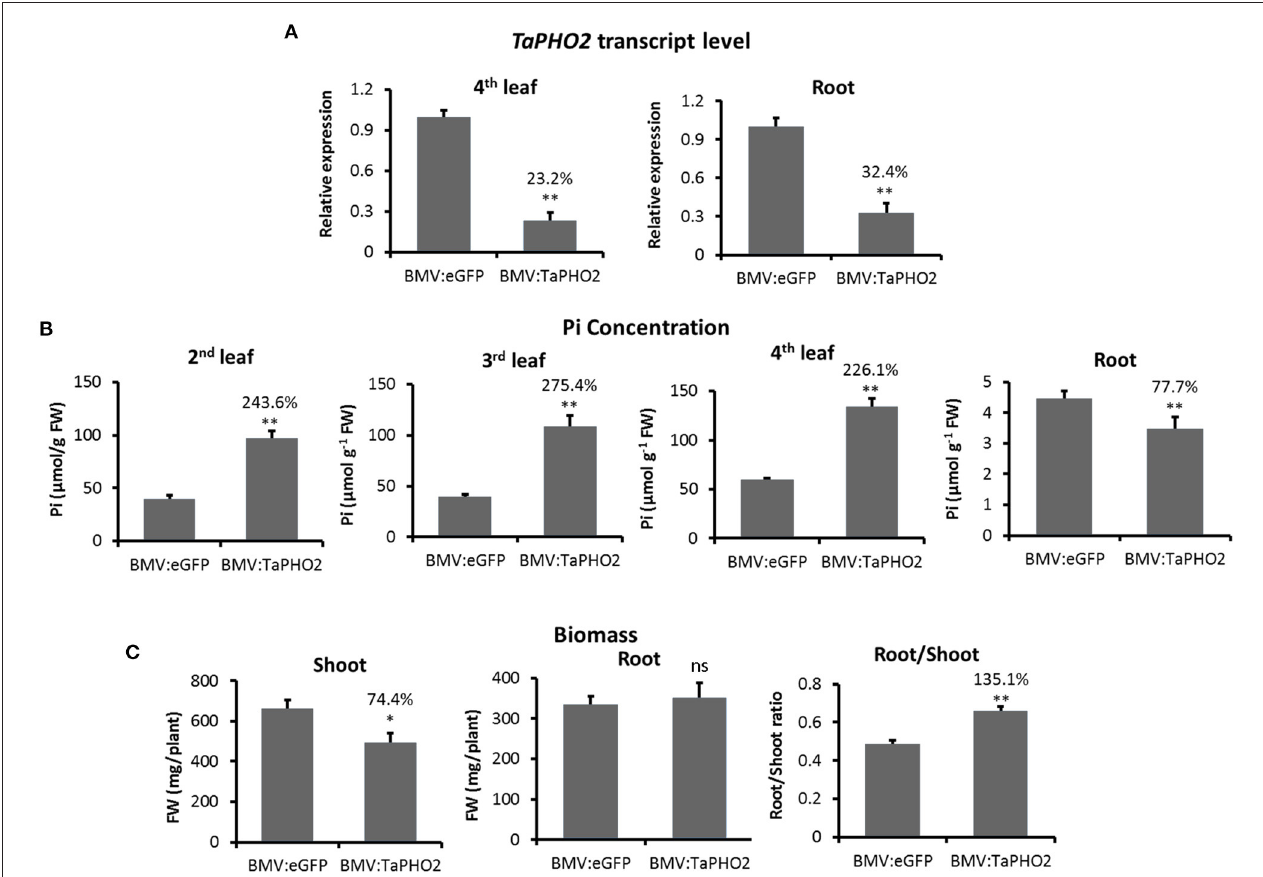
FIGURE 6 | Inorganic phosphate concentration and biomass of wheat plants silenced for TaPHO2 expression with BMV:TaPHO2 114 infection. Wheat ( cv. Overley) plants inoculated with BMV:TaPHO2 (114-nt insert) or BMV:eGFP (107-nt insert; control) were grown under a low phosphate condition (20 µ M Pi). Samples were collected at 24 dpi. (A) TaPHO2 expression levels in the 4th systemic leaf or roots, determined by RT-qPCR with values across treatments normalized against relative TaEF1 α mRNA levels. (B) Pi concentrations in the 2nd, 3rd, or 4th systemic leaves or roots of plants inoculated with BMV:TaPHO2 or BMV:eGFP. (C) Shoot biomass, root biomass and Root/Shoot ratio of plants inoculated with viruses. Percentage values are relative to the BMV:eGFP control. Values represent means + SE of five biological replicates and treatment values compared ( t -test; * P < 0.05; ** P < 0.01). Similar results were obtained in two independent experiments. ns, not